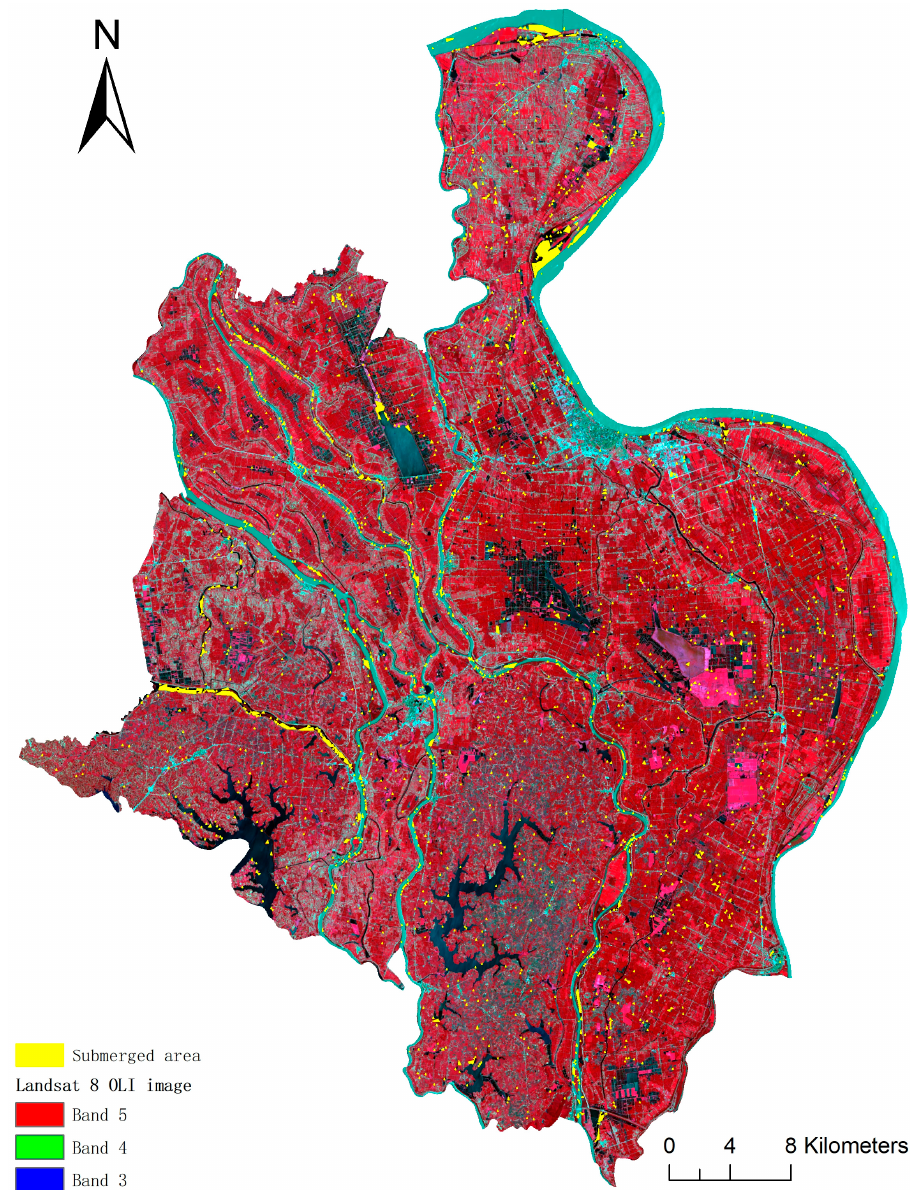
Figure 3. Submerged area.